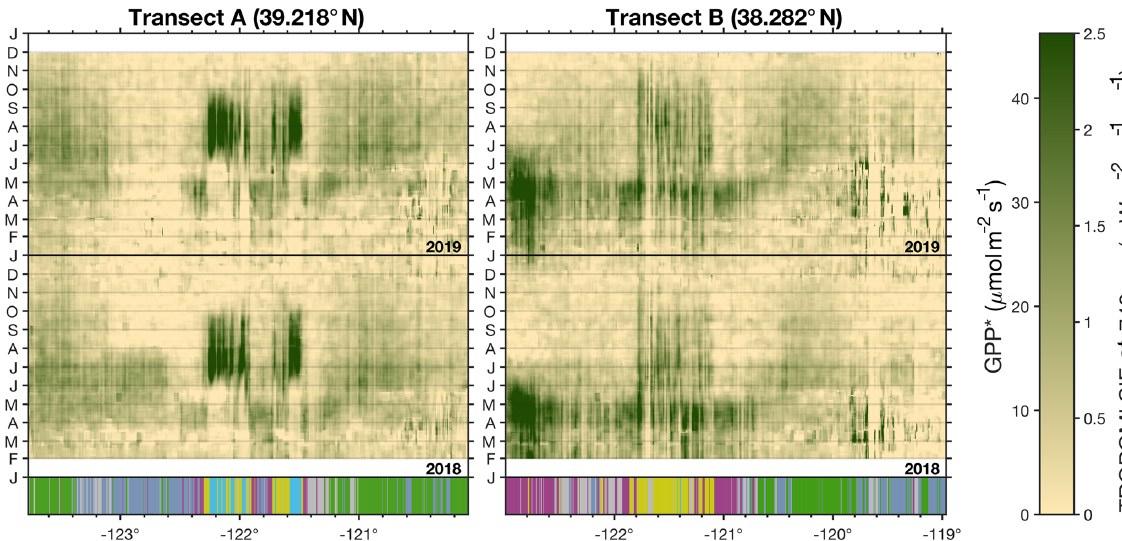
Figure 7. Hovmöller diagrams for three transects across California. Panels show Hovmöller diagrams from February 2018 to November 2019 for the two transects shown in Fig. 1. Bottom bar indicates the dominant land type with coloring from Fig. 1: green is evergreen forest, purple is grassland/pasture, cyan is rice, yellow is cropland (excluding rice), blue is shrubland, and gray is other.